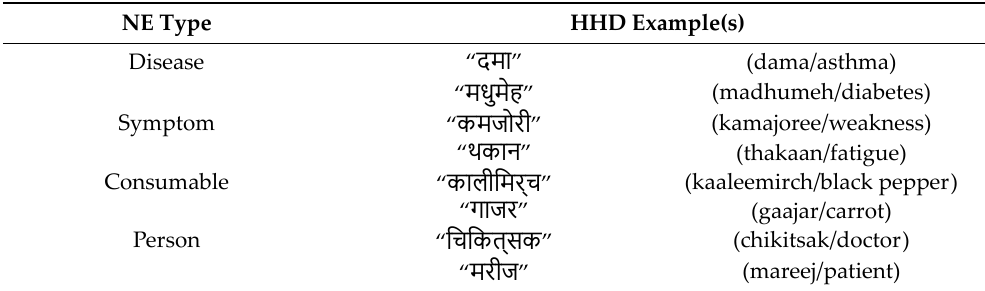
Table 3. Sample NEs within HHD